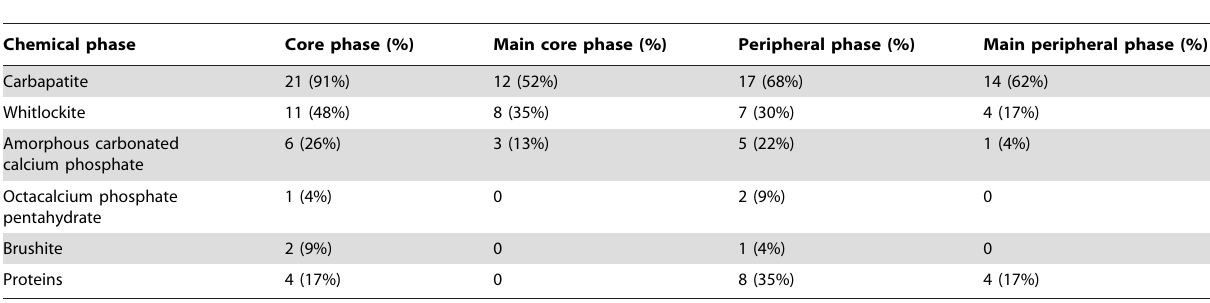
taken at low voltage ( # 2 keV). Stones were imaged at similar magnification for comparison. Table 1 summarizes the age of patients, the chemical components of the 23 samples in the core and peripheral layers (main phases [ . 5%], minor phase [ , 5%]), the clinical data regarding urinary tract and prostate infection, and the presence of bacterial imprints seen by SEM. Several chemical phases (9 Table 2. Nature and frequency of main chemical phases in 23 prostatic